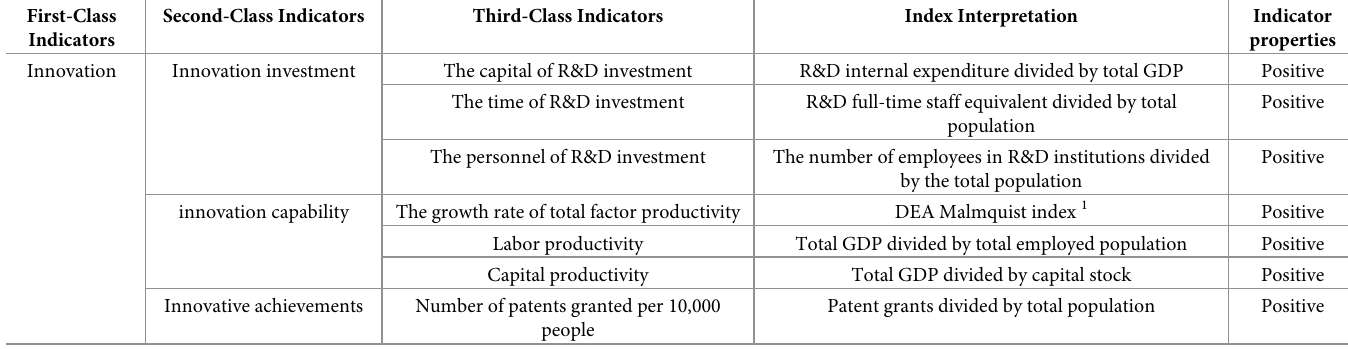
Table 1. Indicator system of high-quality economic